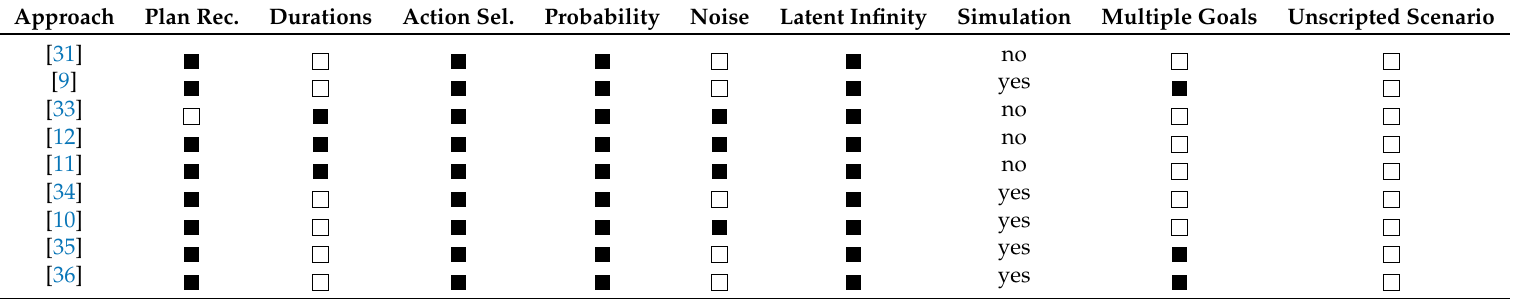
Table 1. Existing CSSMs applied to activity and goal recognition